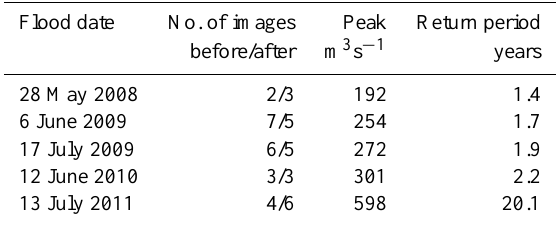
Table 2. Analysed floods in this study in the period 2008–2011. The return period of the flood peaks is estimated from data for the period 1982–2011 at Bignasco (Source: MeteoSwiss and